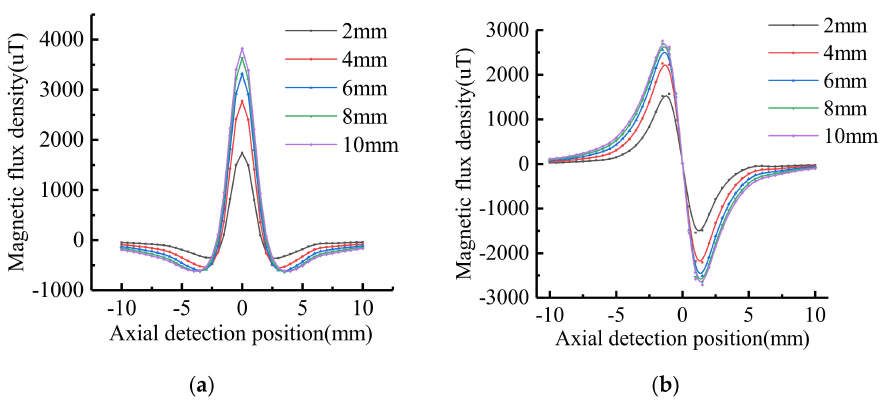
Figure 11. The MFL signals with stress operators at different widths: ( a ) Tangential signal; ( b ) Normal signal.